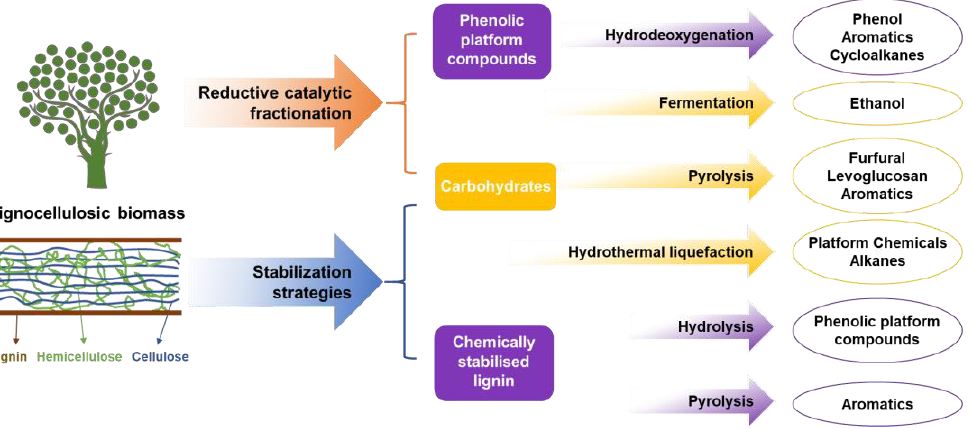
Figure 2. Complete conversion of all lignocellulose components yielding fuels and chemicals based on the lignin-first strategy.